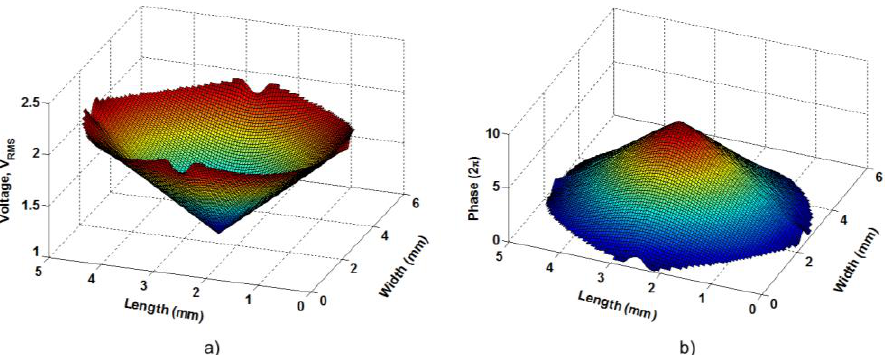
Figure 3. ( a ) Voltage and ( b ) optical phase shift distribution, in three dimensions, of the proposed structure.